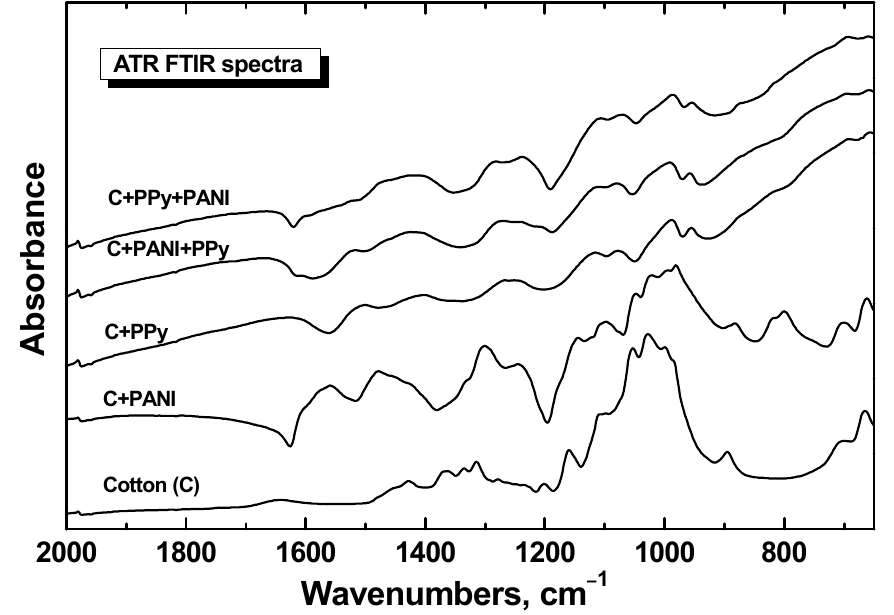
Figure 5. ATR FTIR spectra of cotton fabrics coated with polyaniline (C+PANI) or polypyrrole (C+PPy). Polyaniline-coated cotton was again coated with polypyrrole (C+PANI+PPy) or vice versa (C+PPy+PANI). The spectrum of uncoated textile cotton is included.